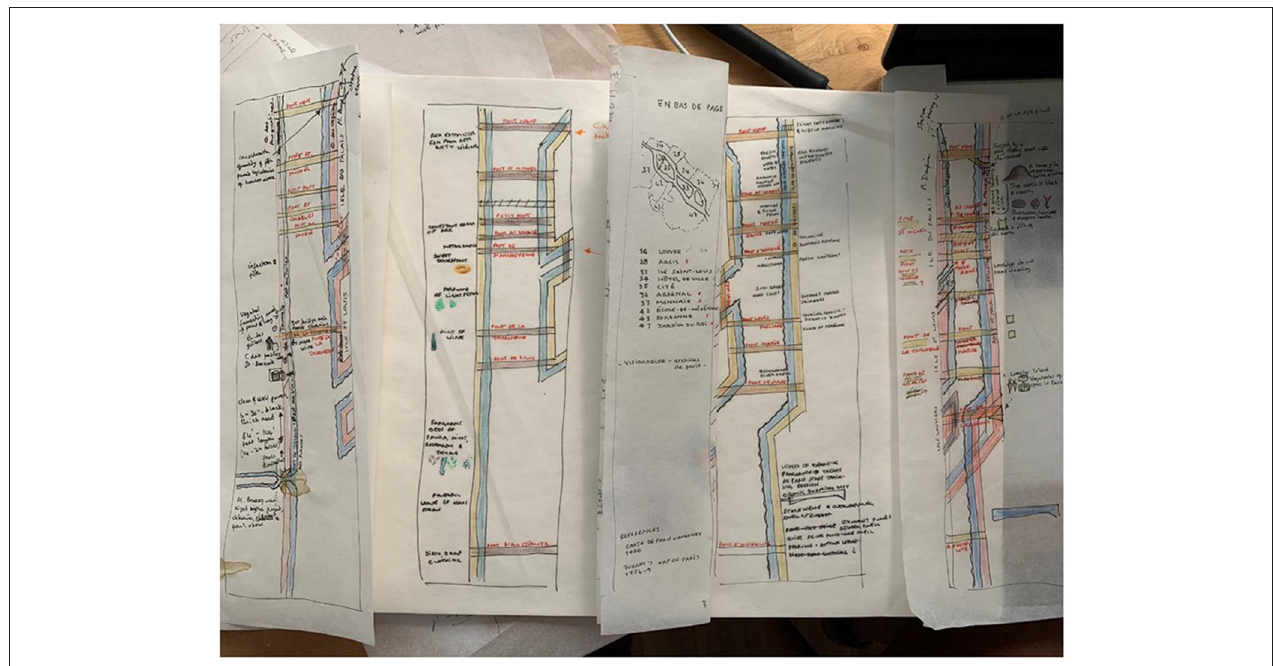
FIGURE 2 | Deploying fictional itinerary mapping practice techniques to depict a historical smellscape alongside a contemporary version ( © Kate McLean,